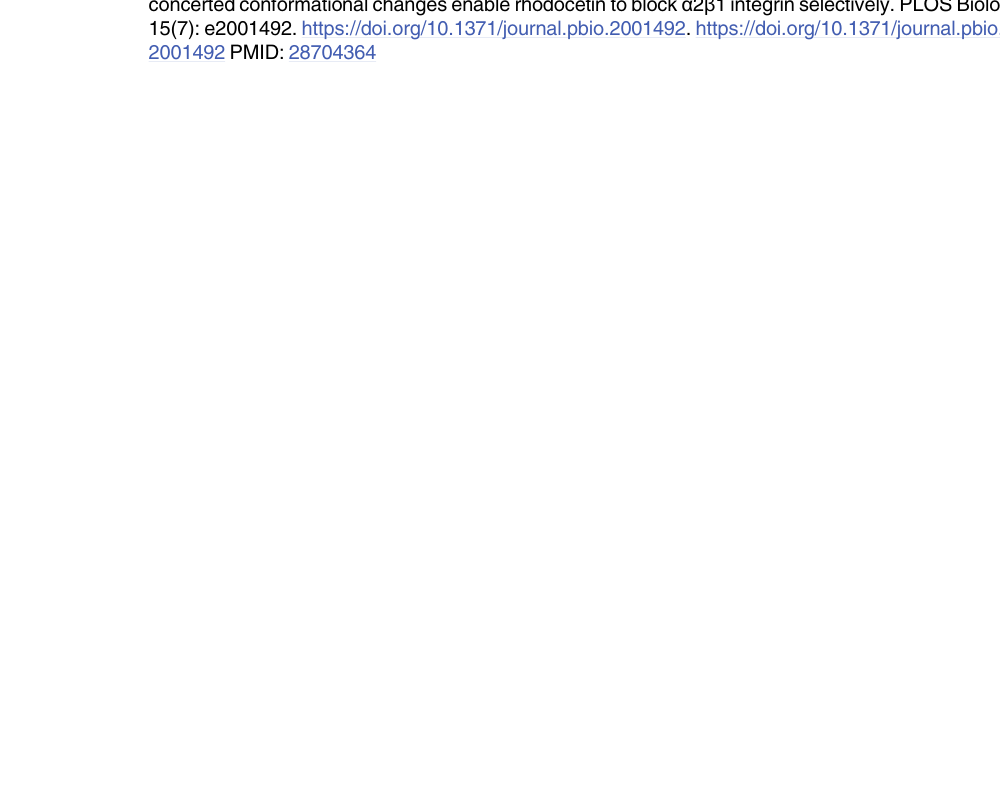
942.40. The labelled peaks correspond to the fragmentation ions of this epitope peptide, as shown in (A). (JPG) S4 Fig. Alignment of integrin α 2A domains from different species. Sequence comparison of the integrin α 2 A-domain from different vertebrate species. The loop 2 sequence S214QYGGD is highlighted in yellow and shows a high degree of homology between different species. Multi- ple sequence alignment was carried out with Clustal Omega Software from EMBL-EBI. (JPG) S5 Fig. Alignment of A-domain of different human integrin α -chains. A comparison of A- domains from different human integrin α subunits. Integrin alpha subunits 1, 2, 10, and 11 belong to the subset of collagen binding integrins. They possess the characteristic helix C (yel- low box, labelled α -C), which is absent in the A-domain of the leukocyte β 2 integrins with their alpha subunits L, X, M, and D. Helix C of the integrin α 2 subunit is the primary binding site for RC γδ and is only present in the “closed” conformation of its A domain. The secondary RC contact site of α 2A is located within the loop 2 sequence S214QYGGD, (yellow box, labelled loop 2) and is specific to the integrin α 2 chain. The secondary structure elements are indicated by the red ( α -helices) and the blue ( β -strands) boxes, respectively. The residue num- bering refers to the integrin α 2 sequence. Multiple sequence alignment was carried out with Clustal Omega Software from